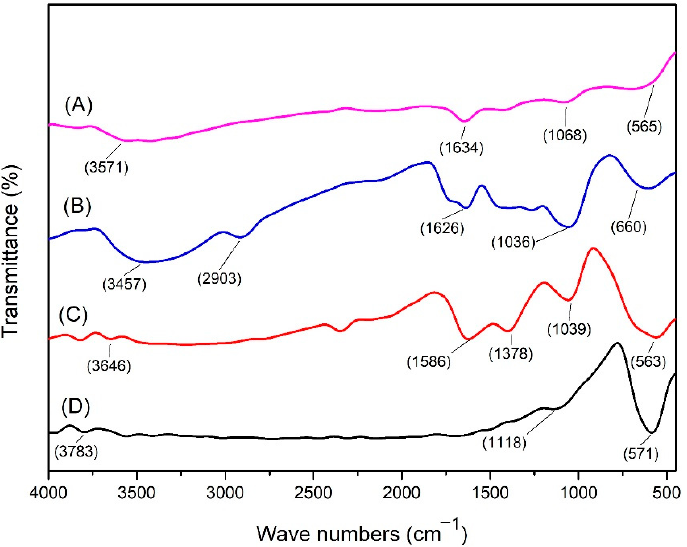
Figure 1. FTIR spectrum for ( A ) magnetic jabon wood from the in-situ method with NH 4 OH; ( B ) untreated jabon wood; ( C ) magnetic jabon wood from the in-situ method with NaOH, and ( D ) the magnetic standard.